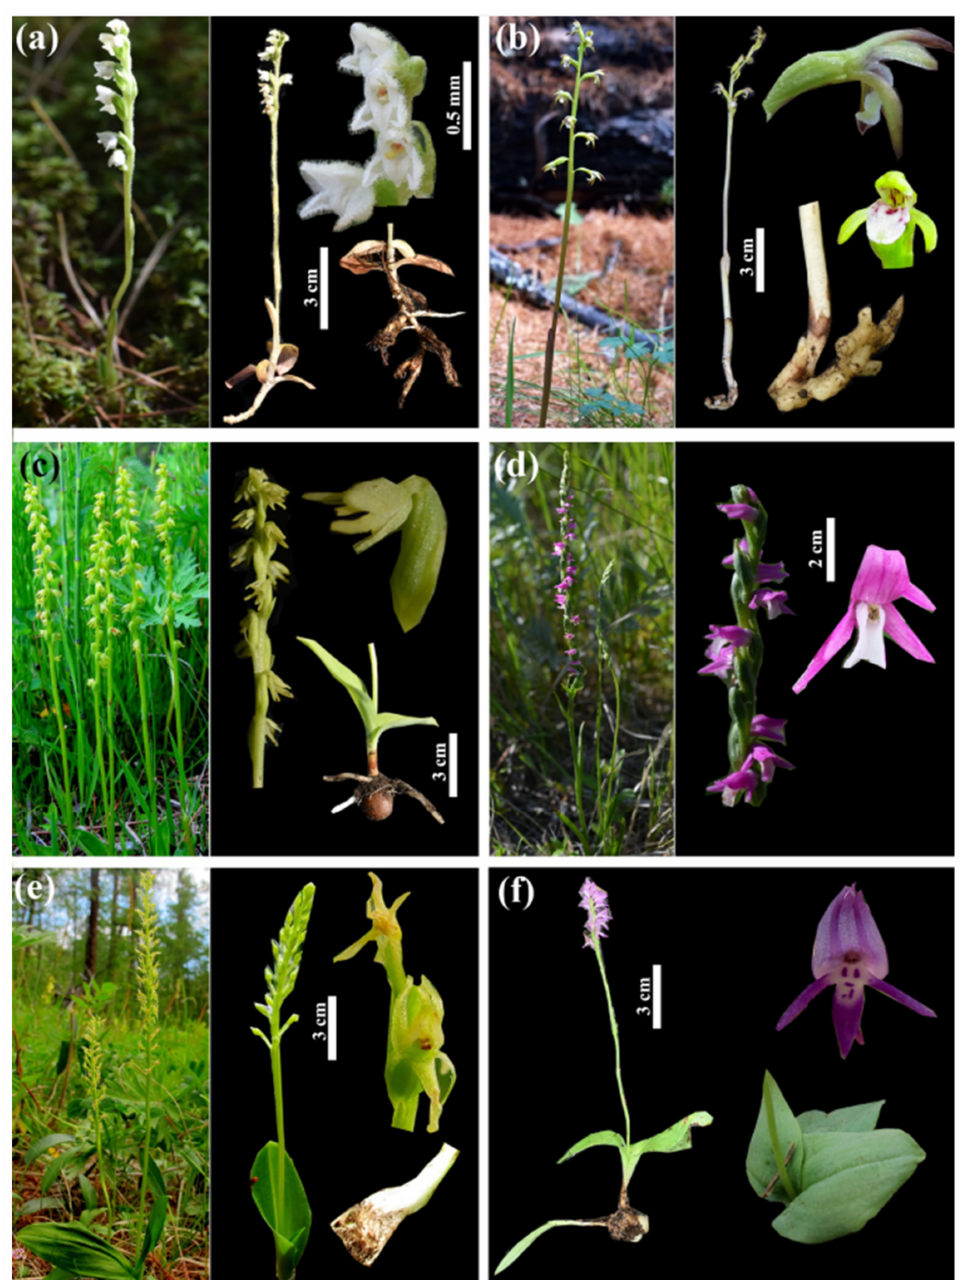
Figure 1. Representative taxa of Orchidaceae in Mongolia: ( a ) Goodyera repens , ( b ) Corallorhiza trifida , ( c ) Herminium monorchis , ( d ) Spiranthes australis , ( e ) Malaxis monophyllos , ( f ) Ponerorchis cucullata . (Photos: ( a – c ) by Sh. Baasanmunkh; ( c – f ) by H.J. Choi, T.